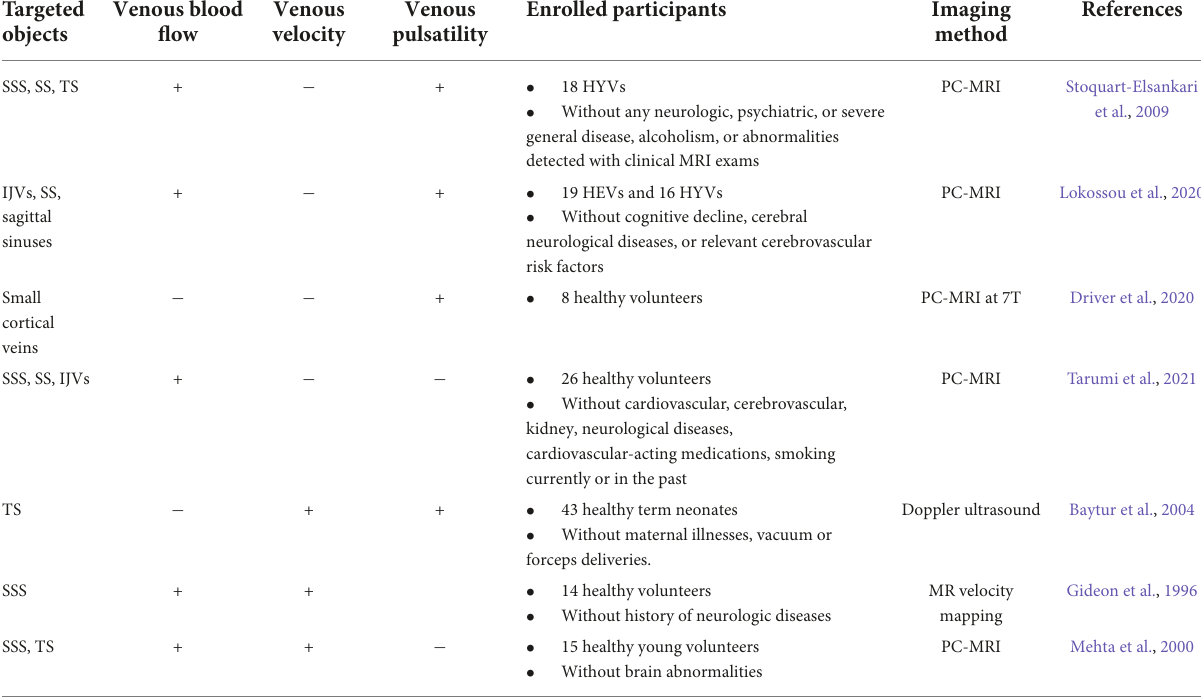
TABLE 5 Cerebral venous hemodynamics accessible by various imaging techniques.